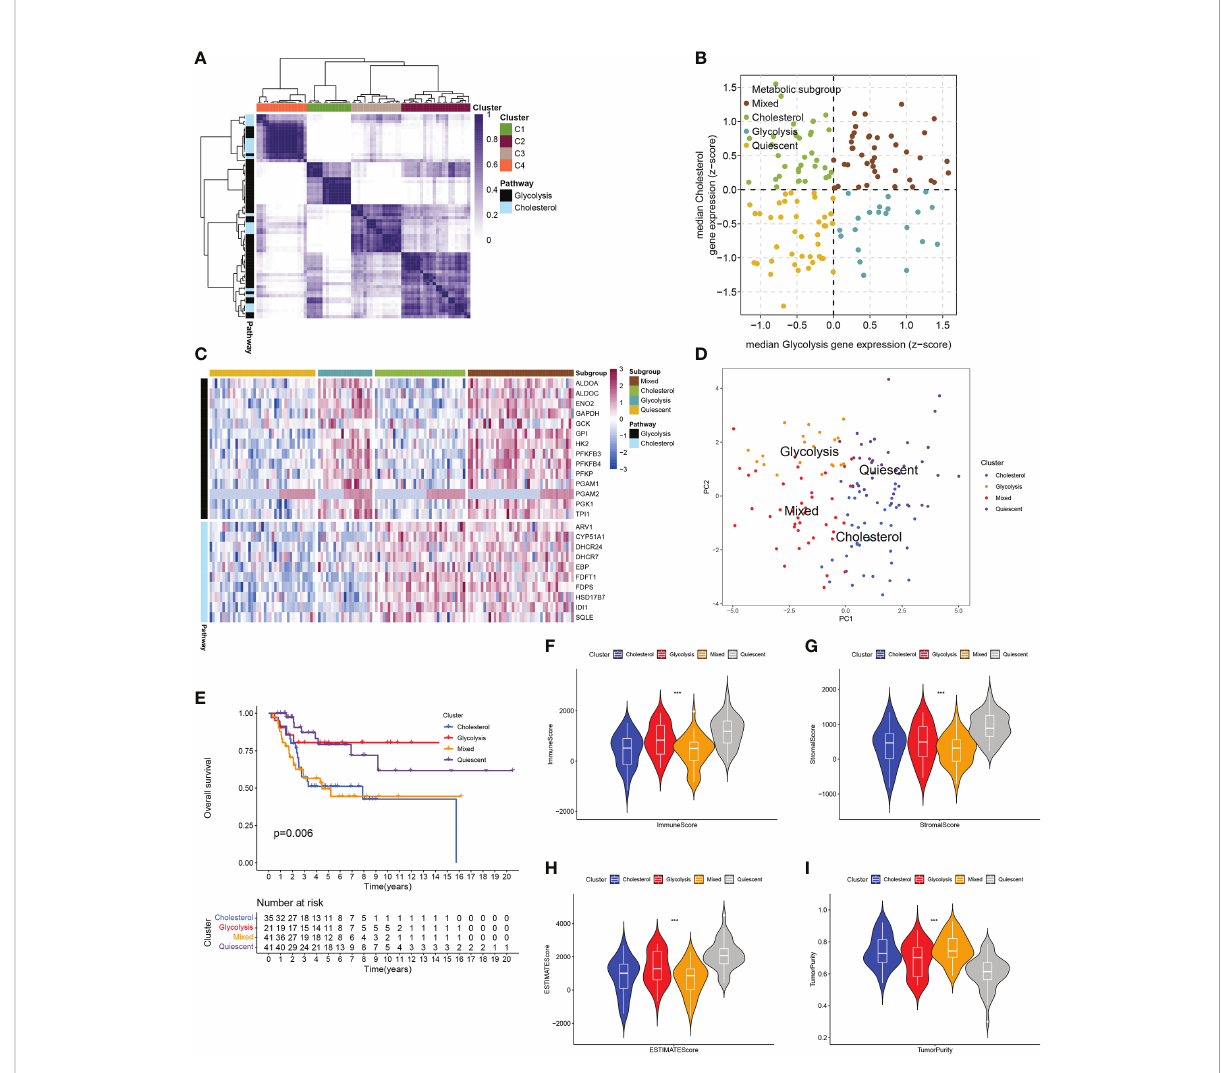
FIGURE 1 Classi fi cation of osteosarcoma patients based on expression of GCSRGs. (A) Heatmap showing consensus clustering solution for GCSRGs in osteosarcoma sample (B) Scatter plot depicting classi fi cation of samples based on GCSRGs expression. (C) Heatmap showing expression levels of co-expressed GCSRGs across each subgroup. (D) PCA showing signi fi cant differentiation between different subgroups of patients. (E) Kaplan- Meier survival curves of patients in the different subgroups. Log-rank test P values are displayed. (F – I) Violin plots showing the immune score, stromal score, ESTIMATE score and tumor purity across different metabolic subgroups. ***P <